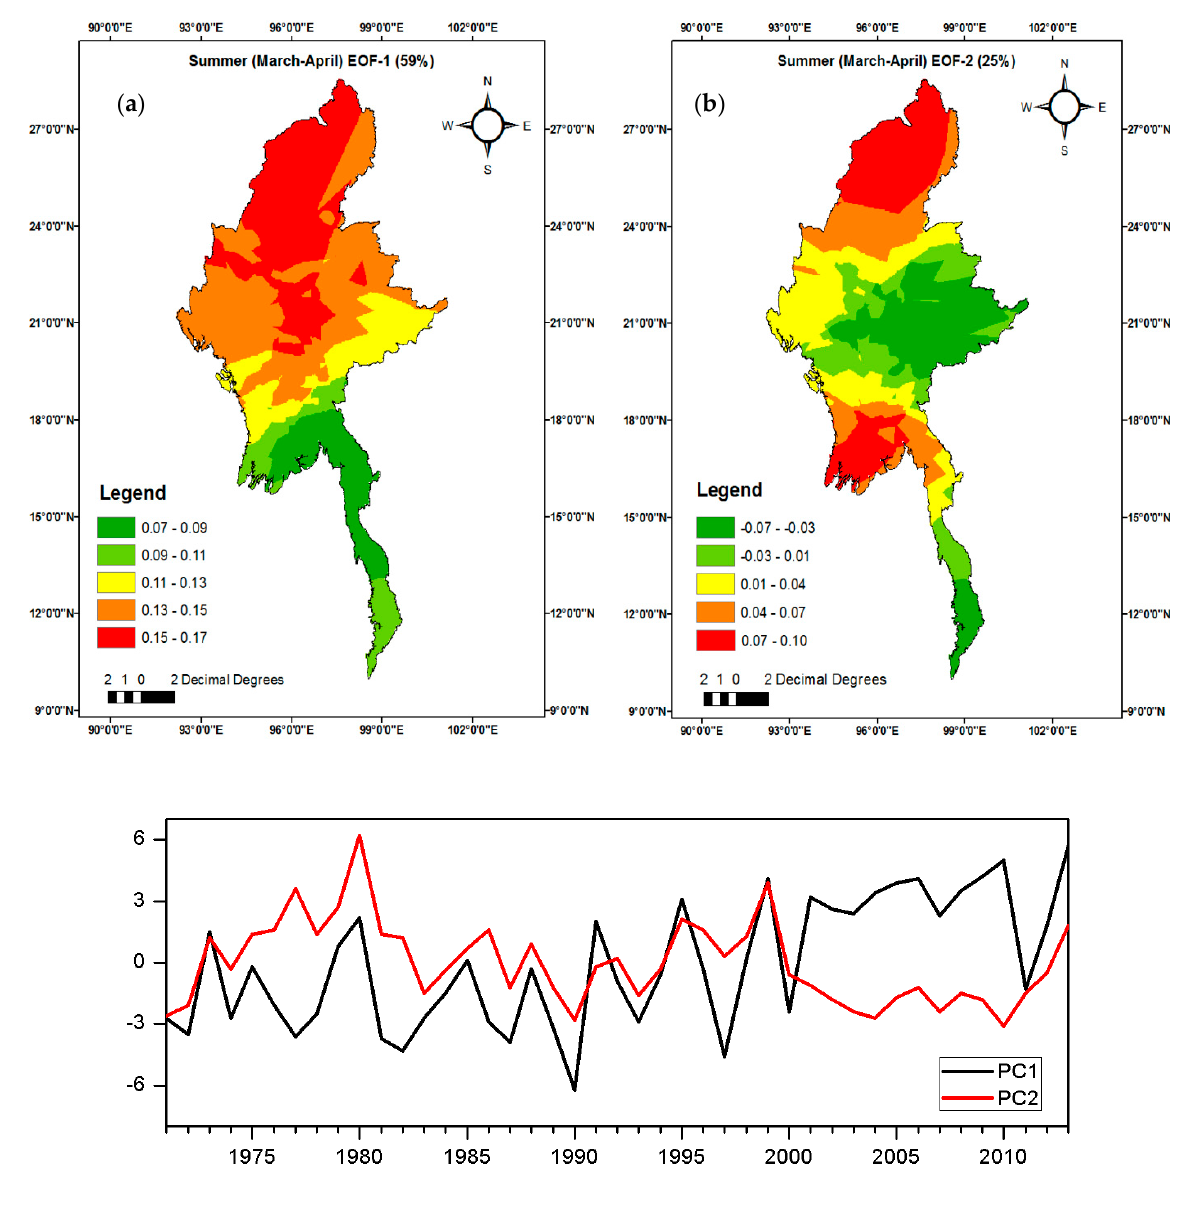
Figure 6. Summer season (March-April) air temperature ( a ), the first mode of EOF ( b ), and the second mode of EOF ( c ) indicates the corresponding air temperature principal components of PC1 and PC2.